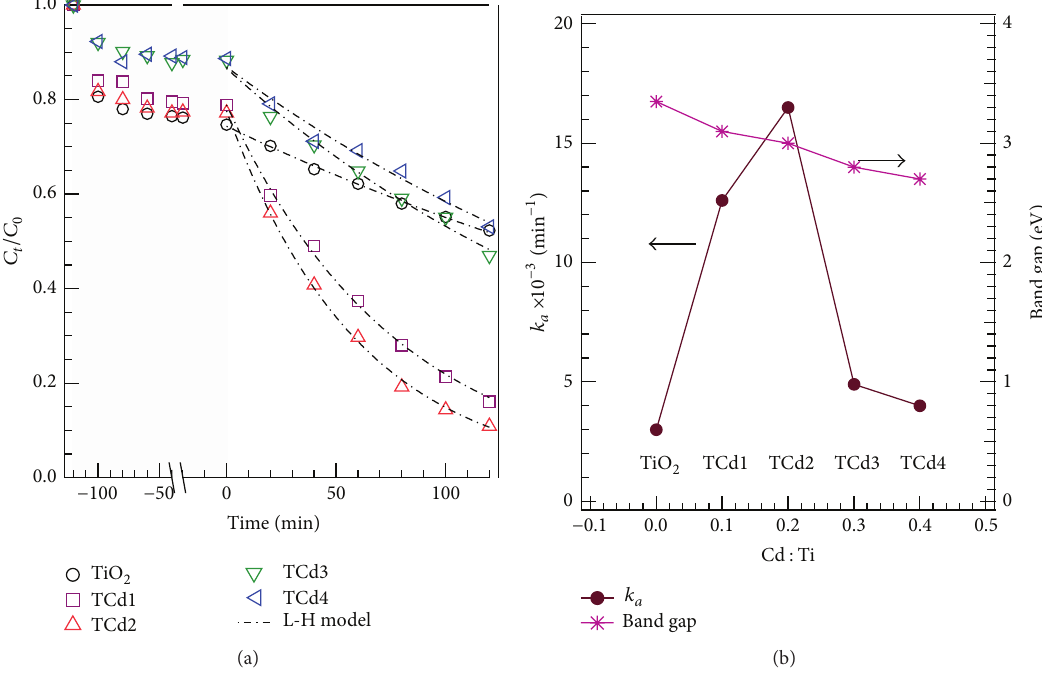
Figure 9: (a) Profiles of photocatalytic degradation of MB with time and NLF of experimental data to the apparent pseudo-first-order kinetics model over the different photocatalysts (white section). (b) Comparison of apparent rate constants 𝑘 𝑎 (blue plot) of photodegradation of MB with the band gaps (red plot) of the corresponding photocatalysts as a function of Cd:Ti molar ratio. Experimental conditions: 0.1 g catalysts, 𝑇 = (300.0 + 0.3) K 35 W Xenon HID light